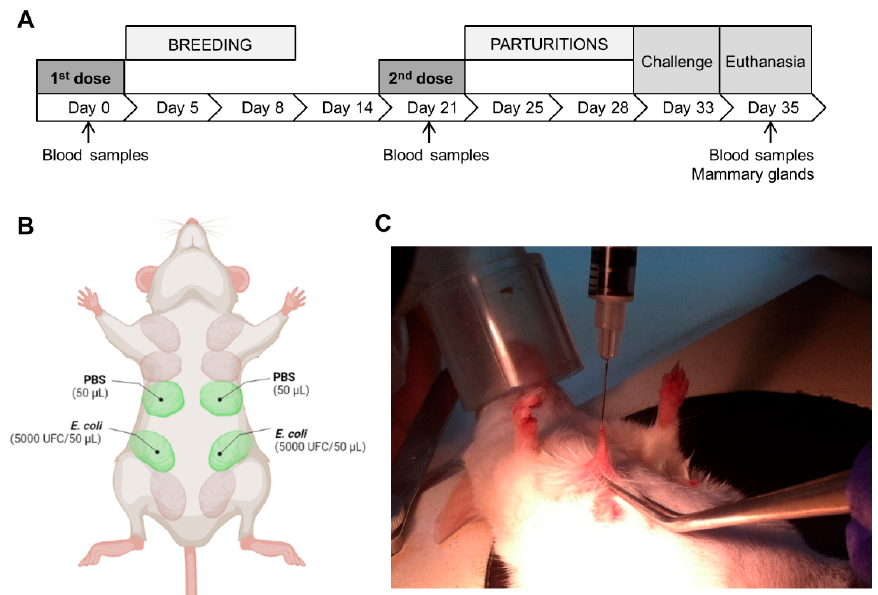
Figure 1. Experimental design and vaccination strategy. ( A ) The first vaccine dose (or placebo) was administered subcutaneously to estrus-synchronized female mice at the beginning of the trial (day 0). Five days after the first immunization, the female mice were mated for 3 days (two female with one male per cage). A second subcutaneous dose of vaccine or placebo was administered on day 21. the fourth gland pair with E. coli RM5278; the third mammary gland pair was inoculated with sterile PBS as a control ( B , C ). At 48 h post bacterial inoculation (day 35), the mice were euthanized, and